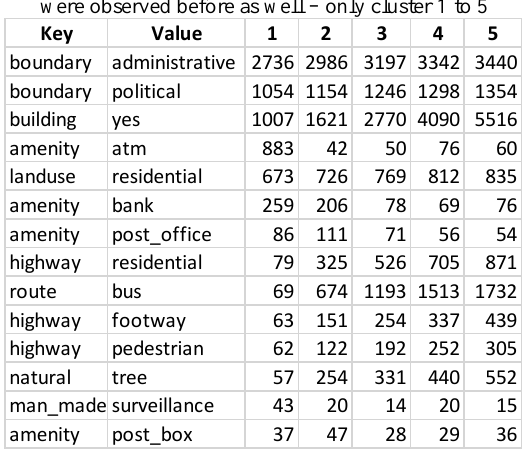
Table 3 . List of objects which exists around current ATM and